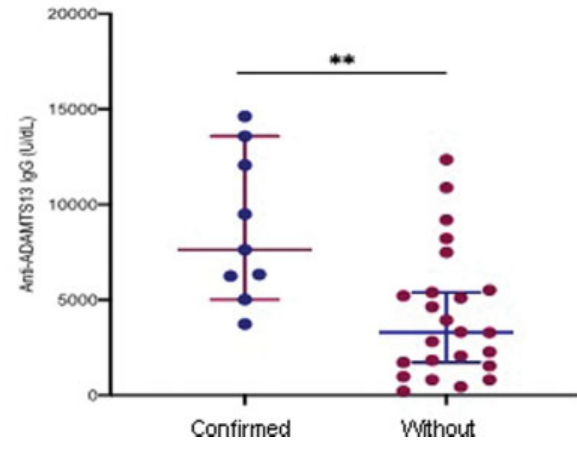
Fig. 1 Plasma anti-ADAMTS13 IgG in patients with iTTP with ( A ) or without ( B ) imaging-con fi rmed stroke. Each dot represents each patient value; the horizontal bars inside dots are median and inter- quartile range (IQR). Mann-Whitney test was performed for statistical signi fi cance between two groups. p < 0.05 is statistically signi fi cant.